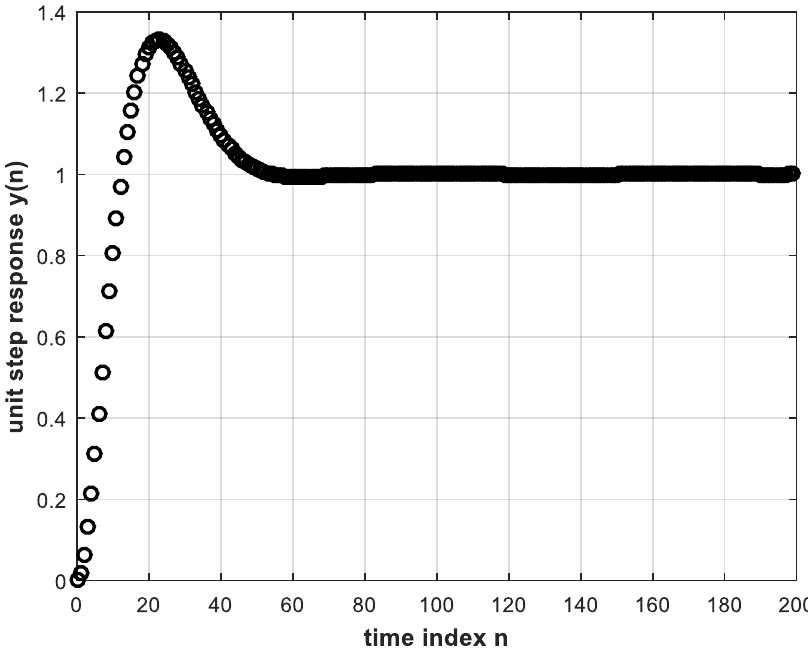
Figure 4. The control signal output from the digital controller.